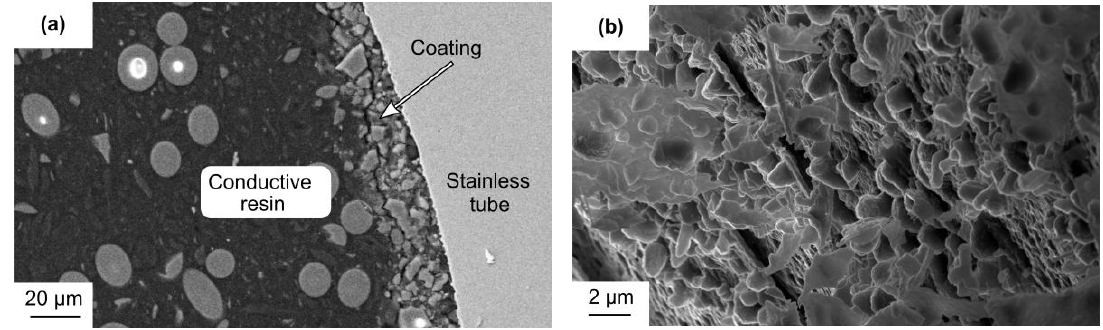
Figure 1. SEM ( a ) cross-sectional and ( b ) frontal images of the catalytic coating in a tube reactor.